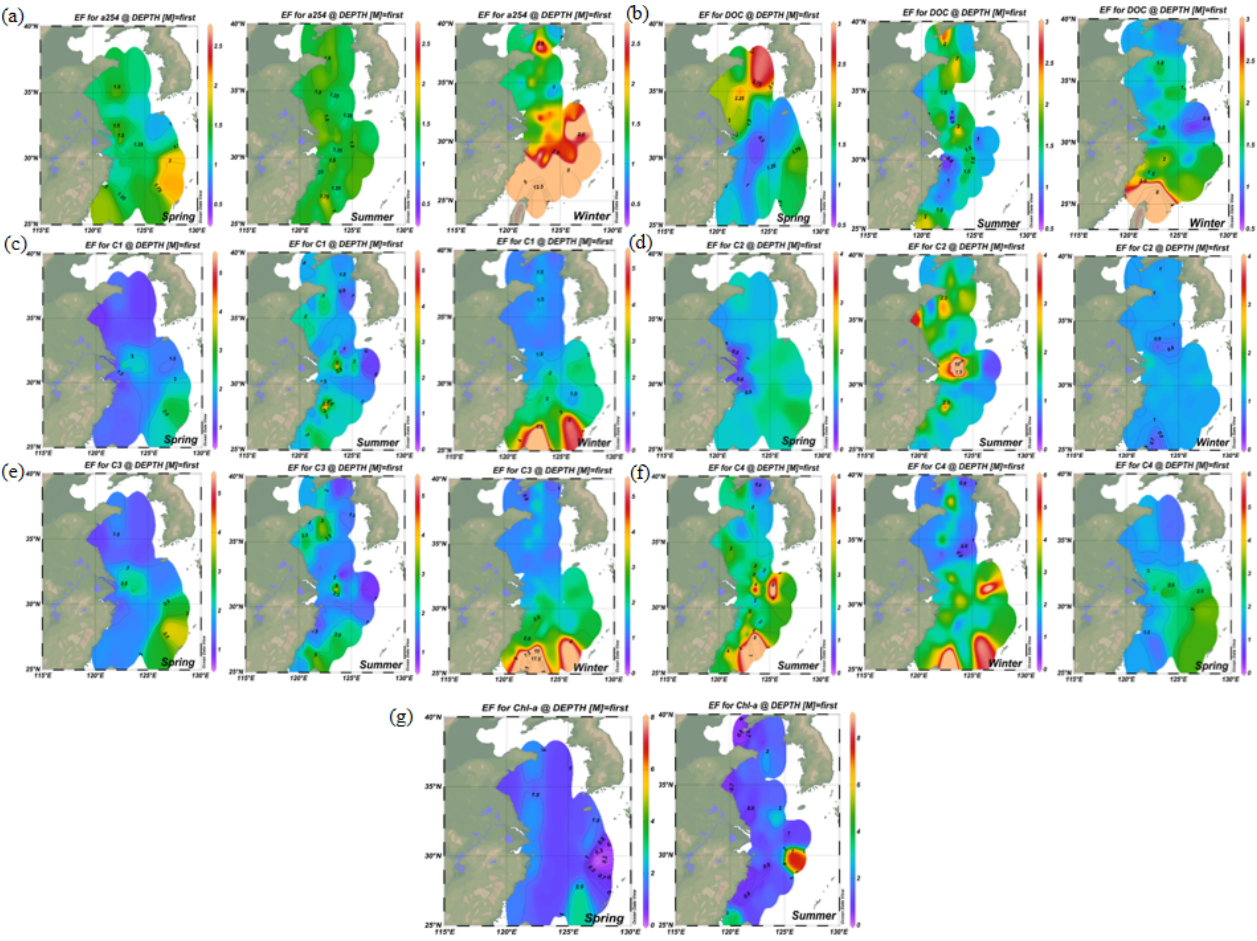
Figure 2. Distributions of enrichment factors of CDOM, DOC, Chl a and four fluorescence components in the surface microlayer water during spring, summer and winter. Increasing DOM yields were significant in coastal regions in all seasons, but the higher enrichment factors (EFs) were more pronounced in off-shore